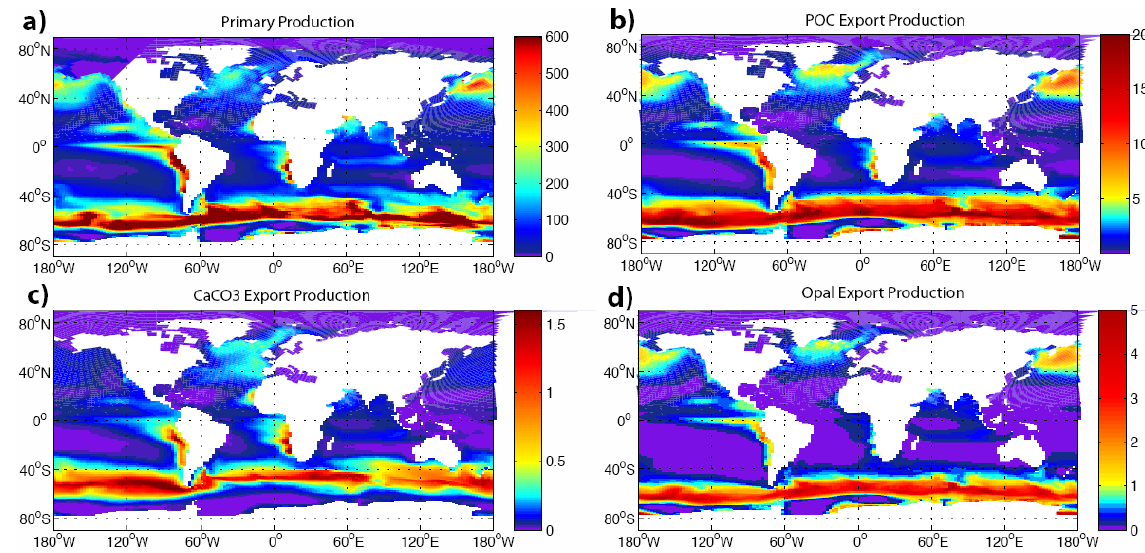
Fig. 14. Mean (1978–2007) simulated (a) primary production (molCm − 2 yr − 1 ), (b) POC export production (molCm − 2 yr − 1 ), (c) CaCO 3 export (molCm − 2 yr − 1 ), and (d) opal export (molSim − 2 yr − 1 ).